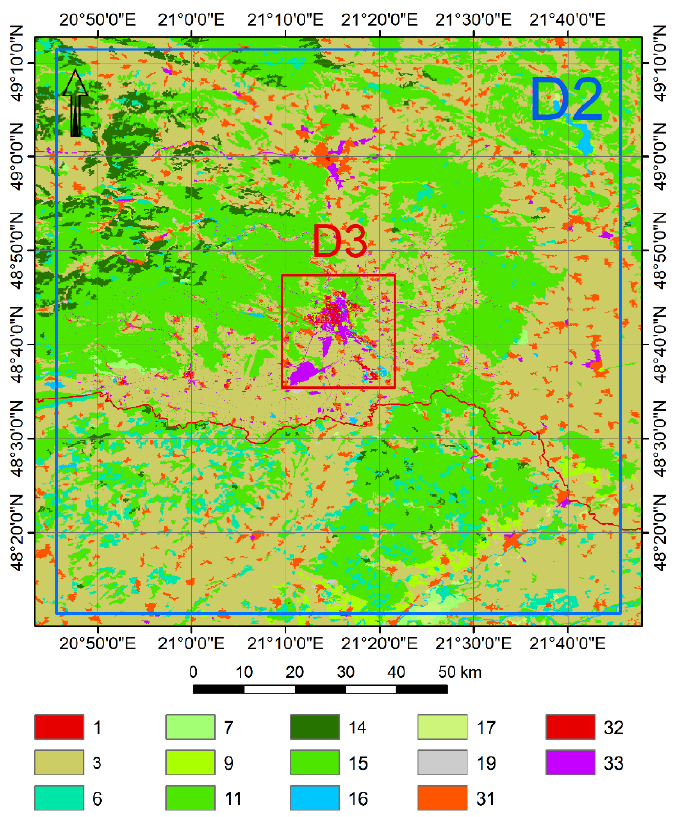
Figure 3. Reclassified land cover classes; key to land cover classes is in Tables A1 and A2.